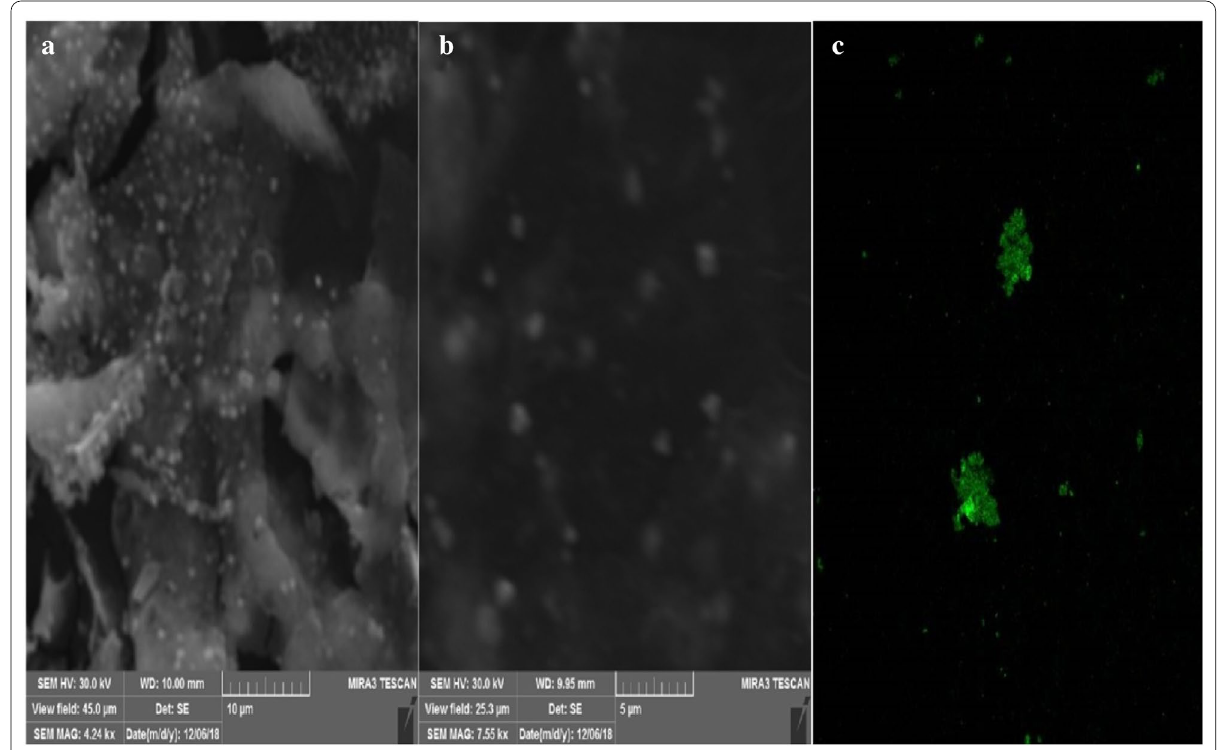
Fig. 5 SEM ( a , b ) and confocal ( c ) images of the SNP synthesized from Leea coccinea leaf